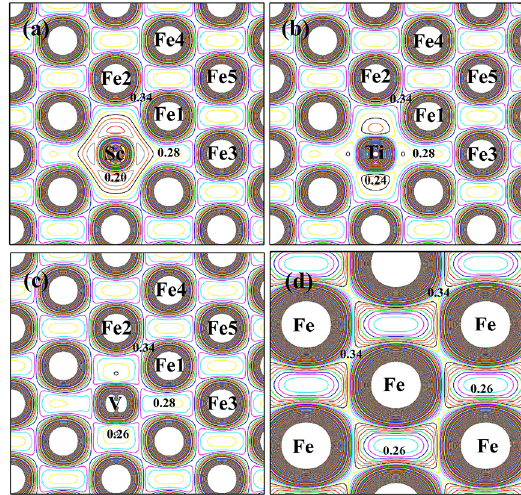
Figure 4. Electron density map in the (110) plane of the bcc structure plotted from 0 e/Å 3 and delta of 0.02 e/Å 3 for: (a) α-Fe(Sc); (b) α-Fe(Ti); (c) α-Fe(V); (d)